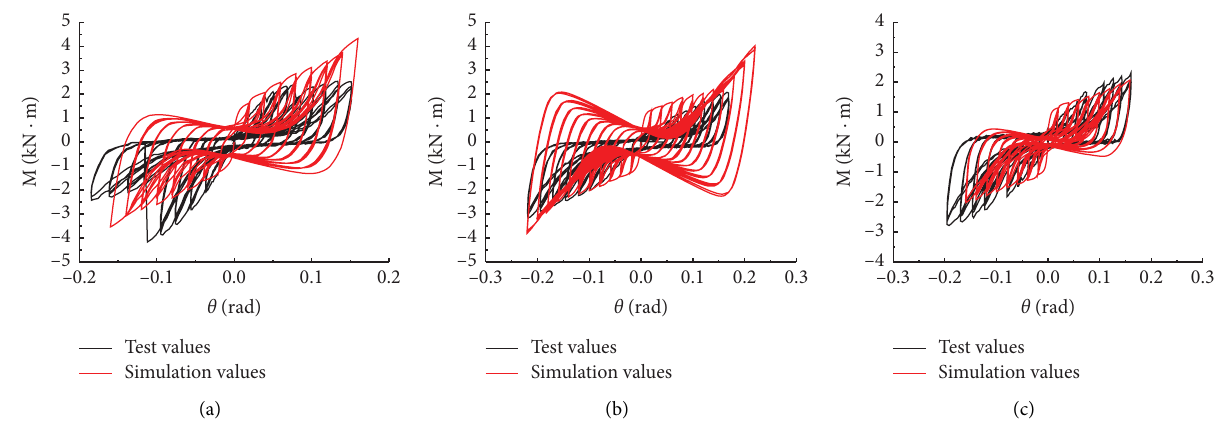
Figure 19: Comparison of moment-rotation hysteretic loops of middle joints of steel plate reinforced: (a) Tou mortise-tenon joints. (b) Ban mortise-tenon joints. (c) Dovetail mortise-tenon joints.